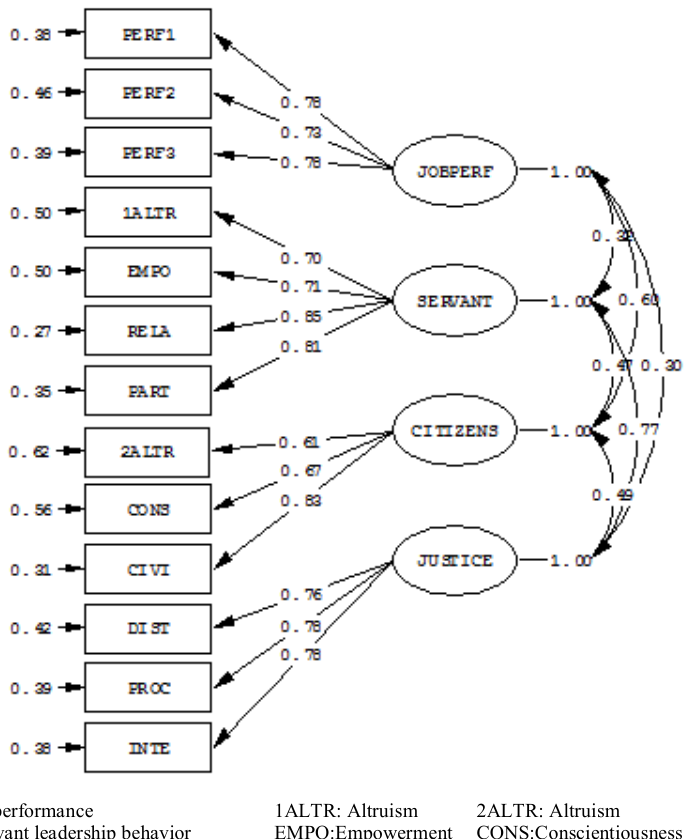
Figure 1. Full measurement